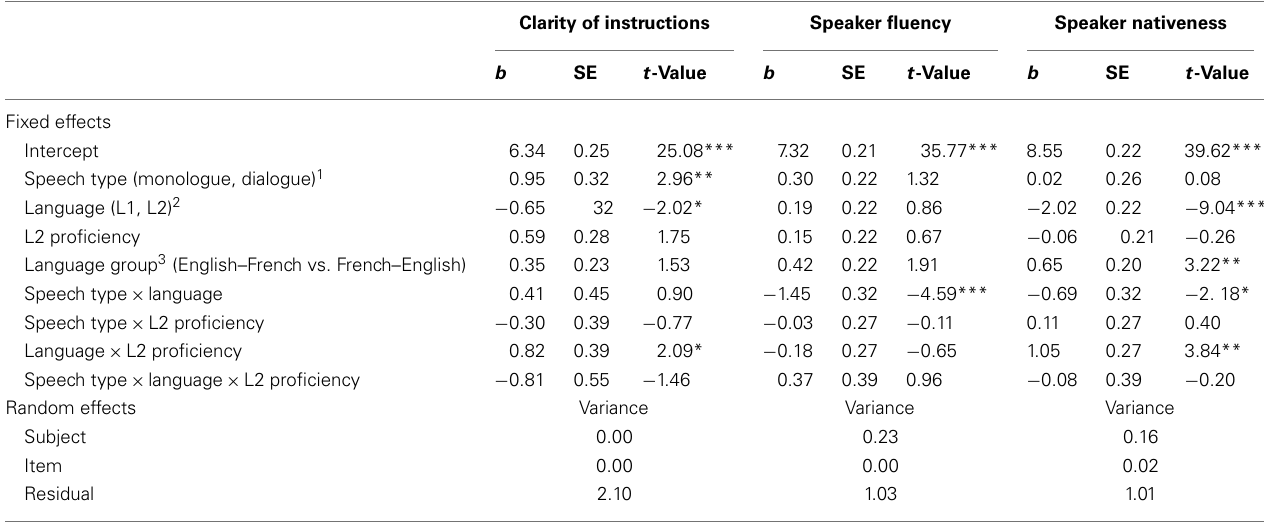
Table 4 | Linear mixed effects models for global output measures (clarity of instructions, speaker fluency, and nativeness) to illustrate interactions between speech type, language, and L2